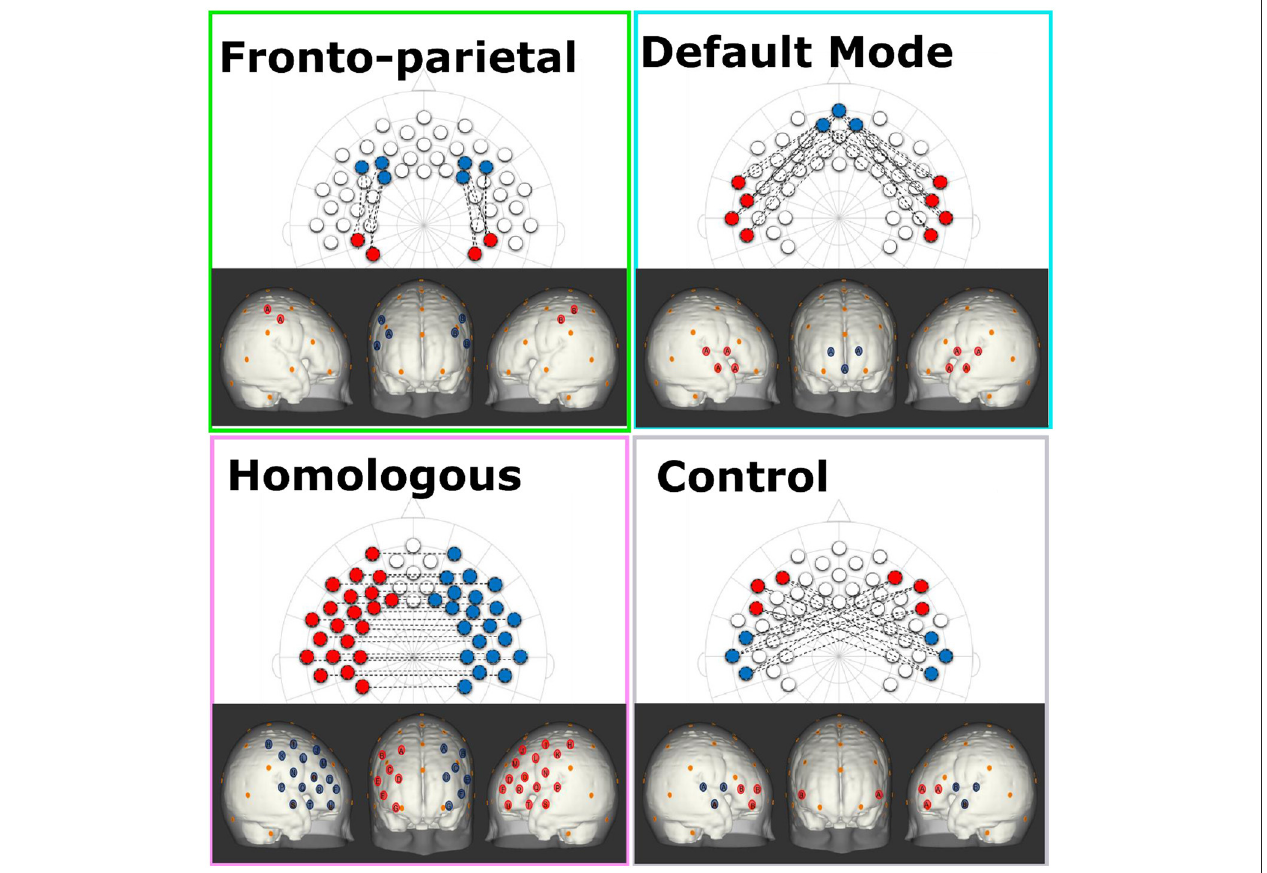
FIGURE 1 | This figure shows the configurations for each of the network patterns in both a 2-dimensional 10-20 system layout and estimated projections onto cortical space of a 0–2 month-old Atlas (70). Each network consists of the average of all of the connections between red and blue channels of the same letter. In addition, the orange dots represent relevant 10-20